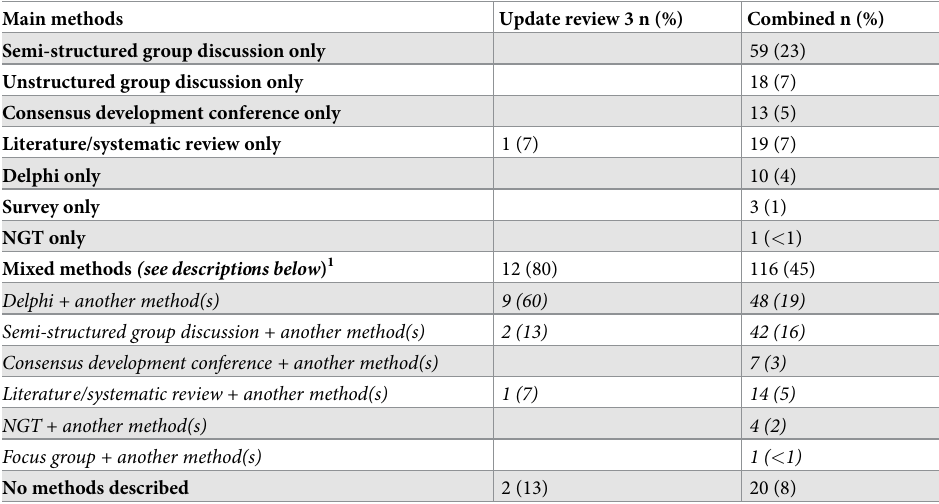
Table 3. The methods used to develop COS (n =